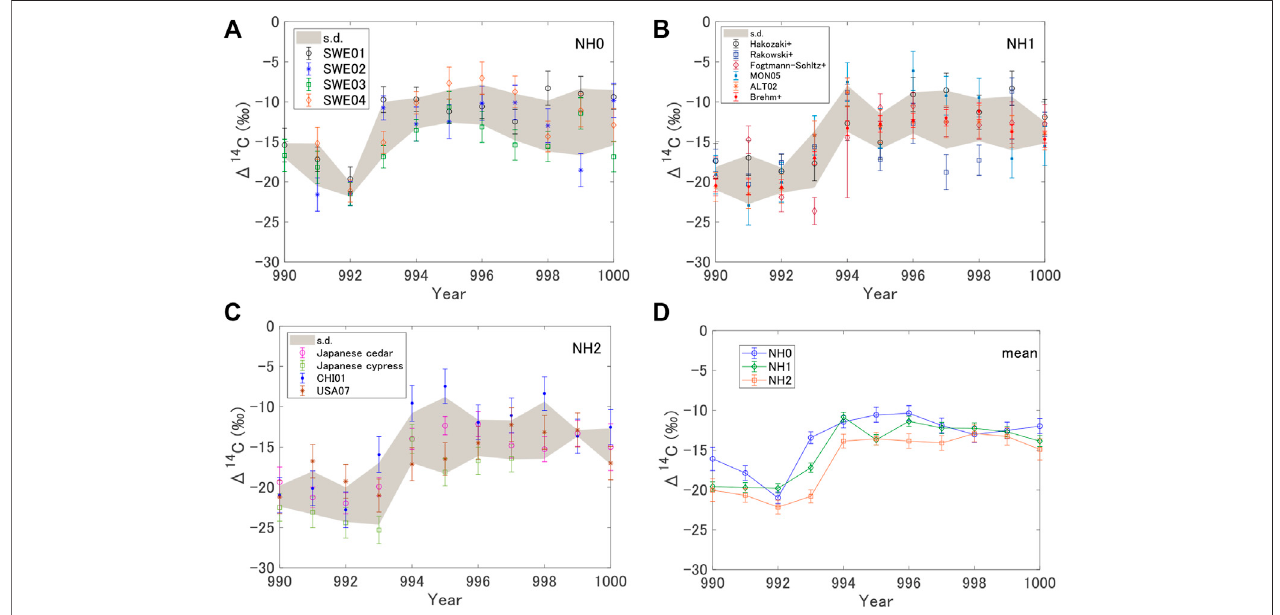
FIGURE 4 | (A – C) Δ 14 C series and its standard deviations (s.d.) for NH0, NH1, and NH2 zones. Since the resolution of the 14 C dataset of Fogtmann-Schltz et al. (2017) isearlywood – latewood-separated,averageddataareshownhere(itserrorofage994CEisthestandarddeviation). (D) WeightedmeanseriesofNH0,NH1,and NH2 zones.